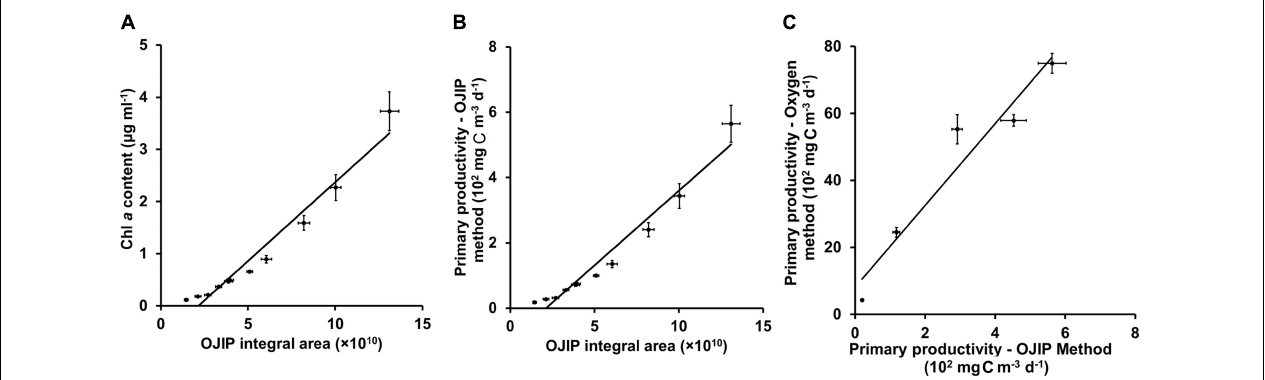
FIGURE 5 | Linear fits for the integral area of the OJIP curve and Chl a content (A) or calculated primary productivity from Chl a content (B) , and for the calculated primary productivity by the OJIP curve method and measured primary productivity by the oxygen method (C) for samples of pond water in Kaifeng City. The basic principle of the oxygen method is to determine the oxygen content in the water to determine the net production of oxygen (mg O 2 m - 3 d - 1 ). Then, we use the photosynthesis equation to calculate the total primary production (mg C m - 3 d - 1 ). TABLE 5 | The parameter modification and validation of the integral area of OJIP curve method for estimating primary productivity by the oxygen method in the pond of Kaifeng City. Integral area (x) – Integral area (x) – Primary productivity Integral area (x) – Integral